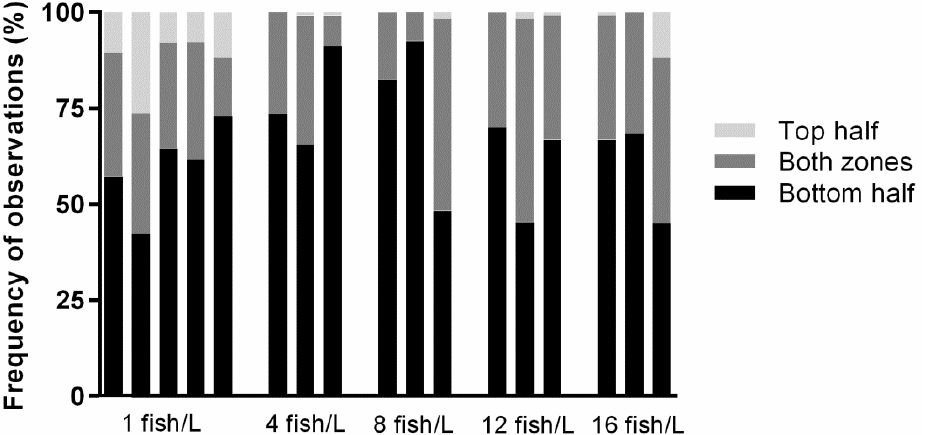
Figure 3. Vertical distribution for each tank holding densities of 1 ( n = 5), 4 ( n = 3), 8 ( n = 3), 12 ( n = 3), or 16 ( n = 3) fish/L, respectively. There were three possible distribution zones: the bottom half of the tank, the top half of the tank, or both zones. The percentage frequency of observations was the number of observations during which 50% of the fish, or more, occupied one of these three zones. For each density treatment, there were three replicates and an additional two for the lowest density. Recorded videos of each tank were analysed twice a day for 30 s during the entire exposure period.